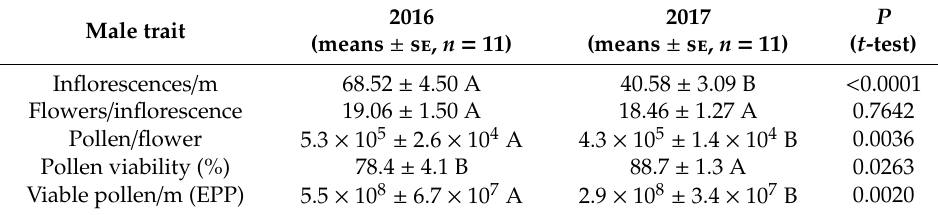
Di ff erent letters indicate significant di ff erences. SE: standard